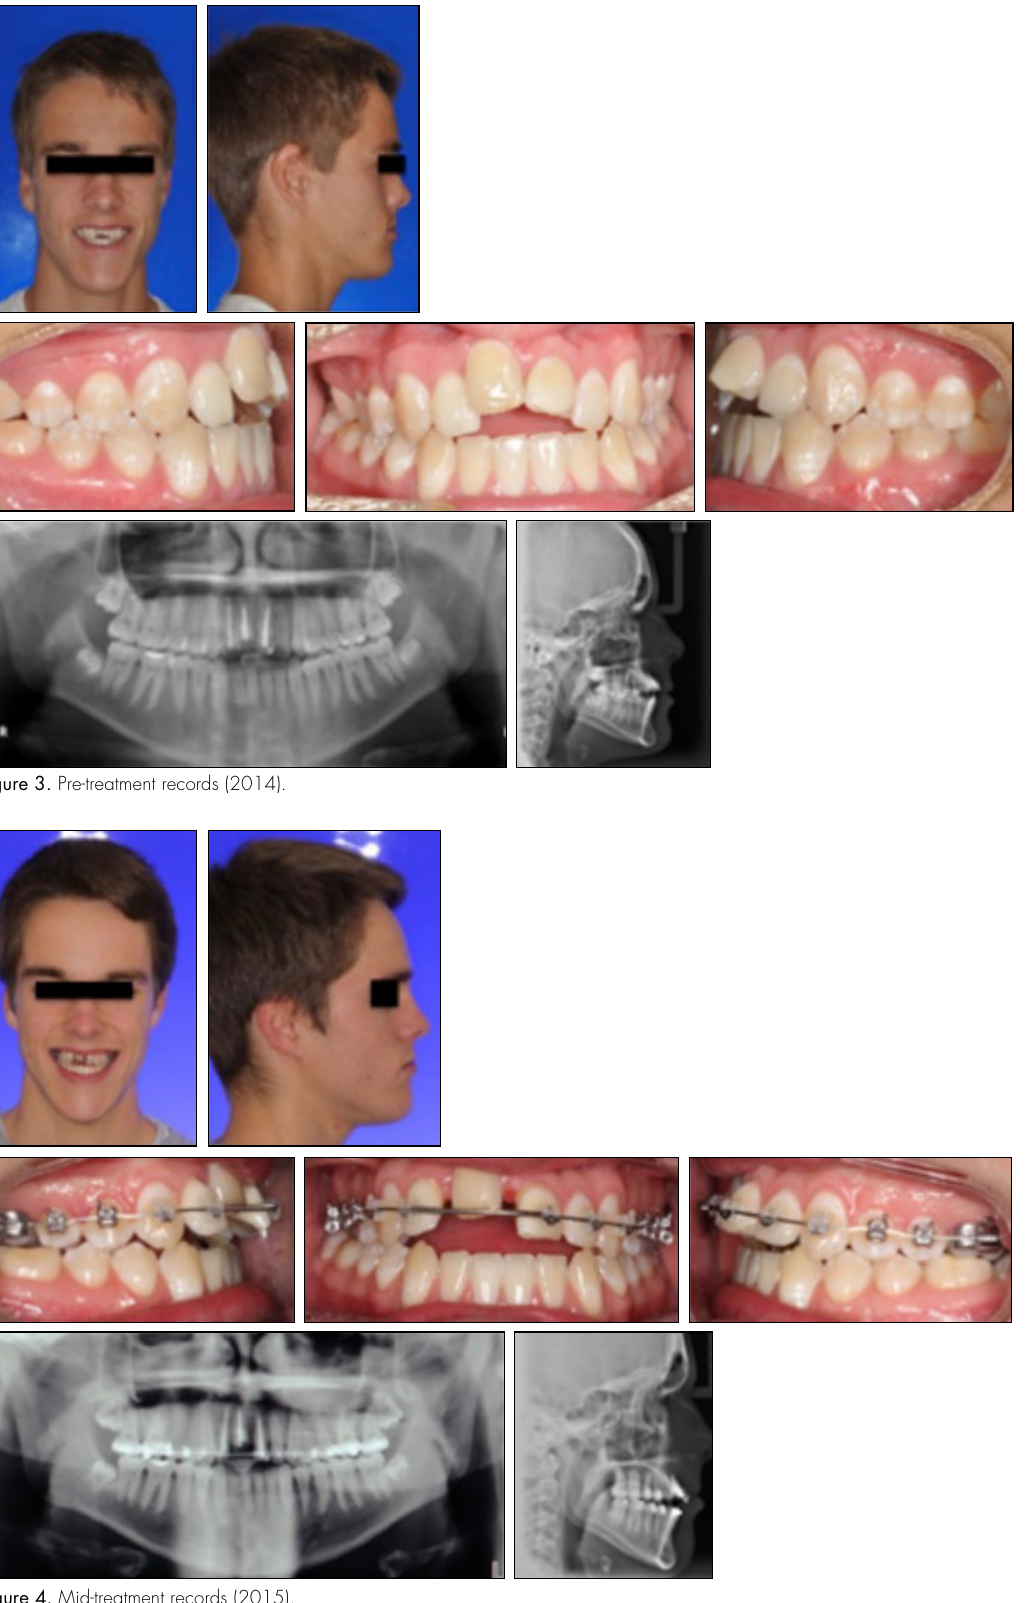
Figure 4. Mid-treatment records